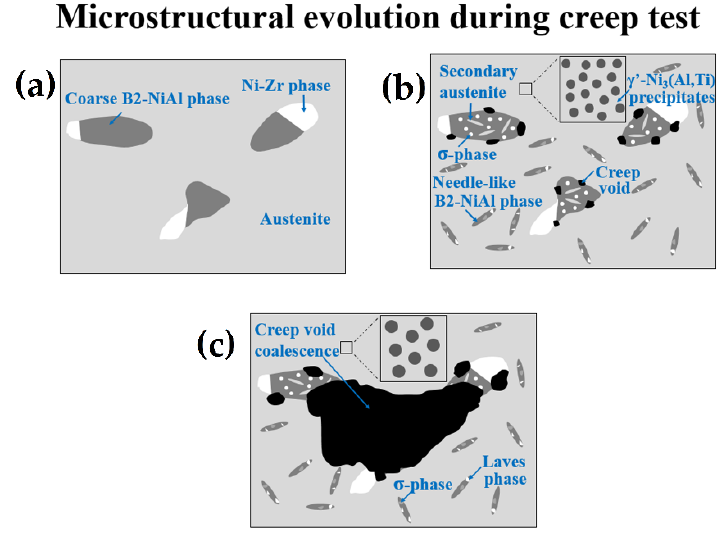
Figure 15. Schematic illustration of the microstructural evolution for the high-Ti alloys (43+ SA and 44+ SA): ( a ) initial microstructure; ( b ) microstructure during creep; ( c ) final microstructure near fracture region.